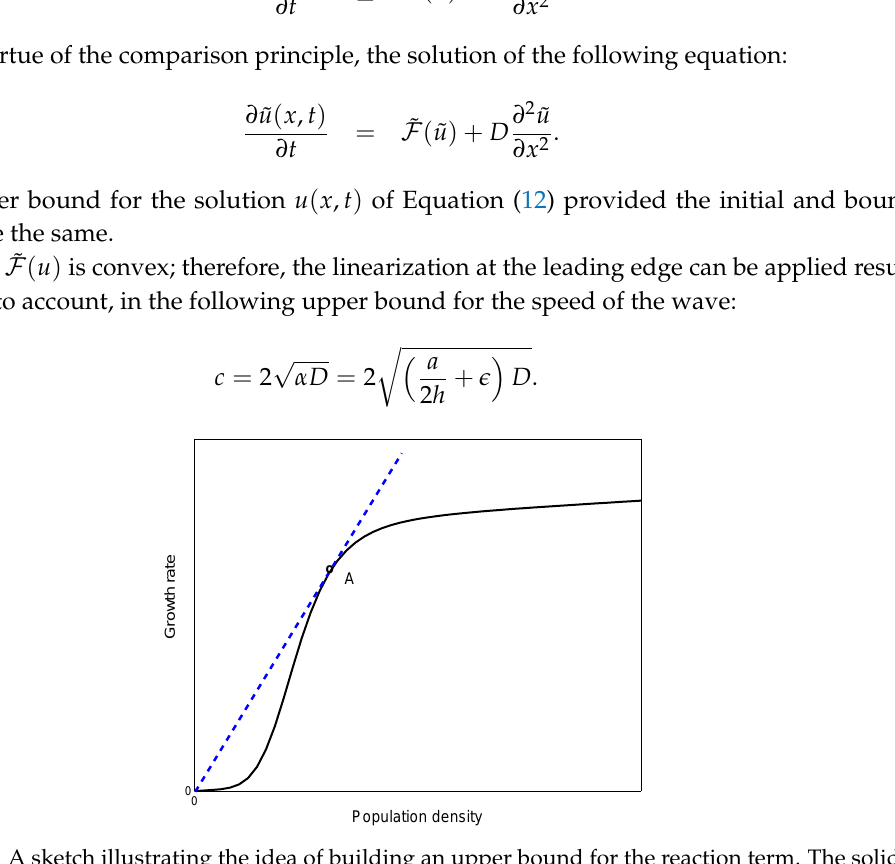
Figure 12. A sketch illustrating the idea of building an upper bound for the reaction term. The solid (black) curve shows the reaction term in the right hand side of (18) (or Equation (12) with m ≡ 0), and the dashed (blue) line shows the tangent line; see more details in the text.